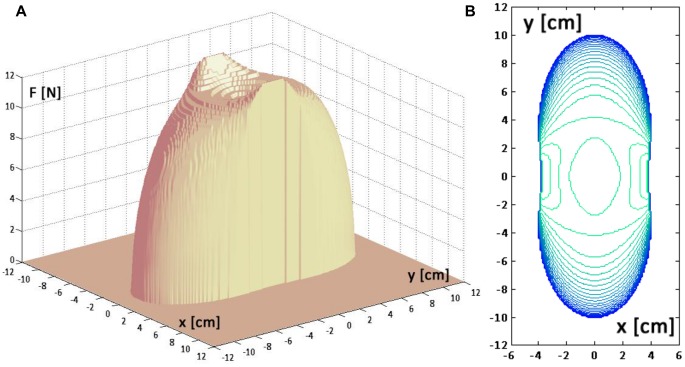
Forces and stability.Distribution over the workspace of the magnitude of the pair of  forces that must be applied in order to reach the condition of marginal stability. Panel A: 3D-plot; Panel B: contour plot. The x-axis corresponds to the medio-lateral direction (the unstable manifold of the force-field); the y-axis corresponds to the antero-posterior direction (the stable manifold).